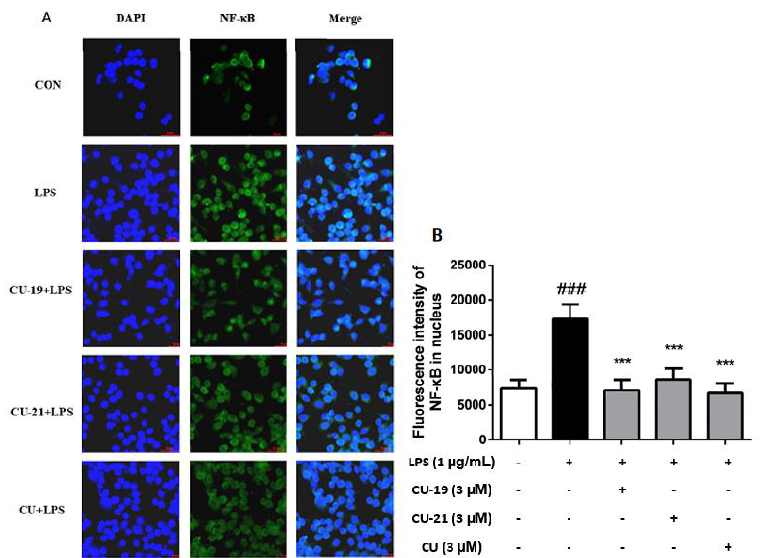
Figure 5. ( A ) The impact of CU-19 and CU-21 on LPS-induced NF- κ B nuclear translocation. BV2 cells were evaluated following a 24 h treatment with CU-19 , CU-21 , CU (3 µ M) and LPS (1 µ g/mL). ( B ) The fluorescence intensity of NF- κ B in nucleus. Results were the mean ± SD, n = 3; ### p < 0.001 vs. control; *** p < 0.001 vs. LPS alone.